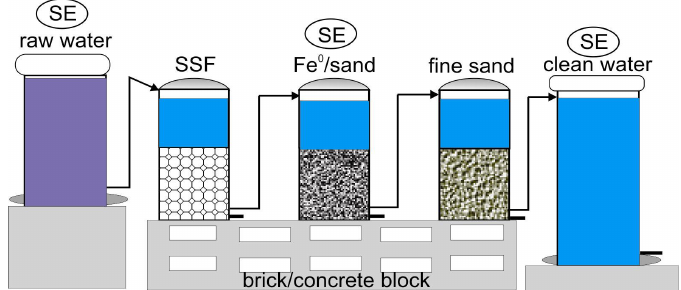
Figure 1. Side view of a sequential Fe 0 -sand water filter. To optimize the efficiency of the